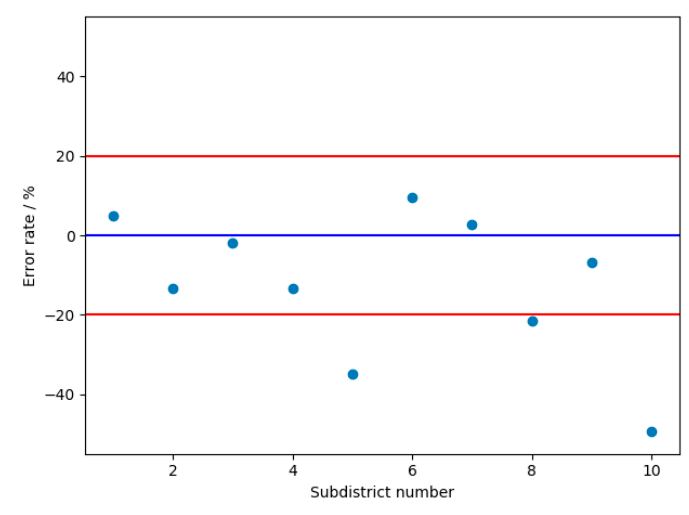
Figure 7. The error of the test set of the population estimation model.